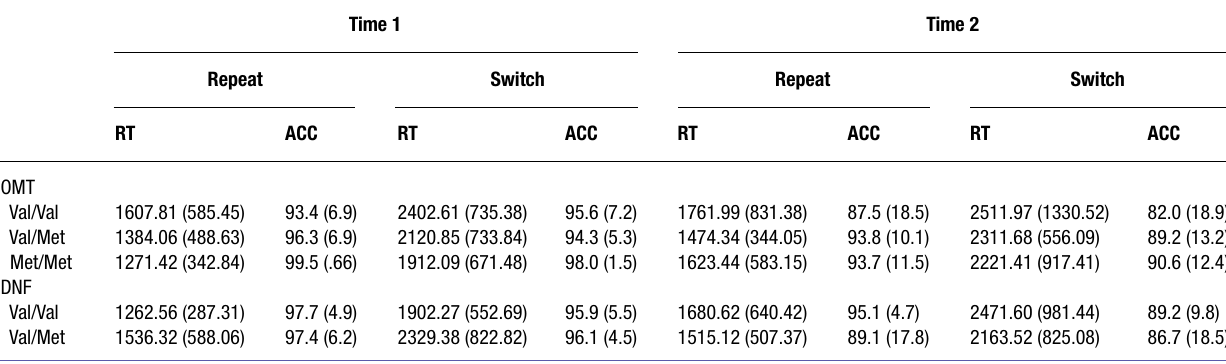
Standard deviations are represented in parentheses. There was a trend for IQ to vary as a function of COMT genotype and the Val/Val form of the polymorphism reliably differed from the Val/Met form. Table 2 | Mean response times and accuracy rates for repeat and switch conditions for both BDNF and COMT